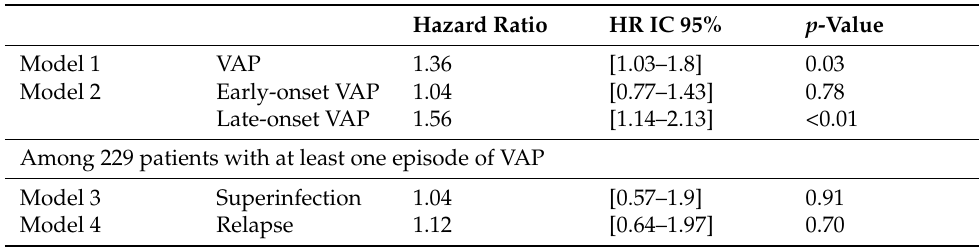
Table 4. Risk factors associated with 60-day mortality, using different survival models (multivariate analysis).